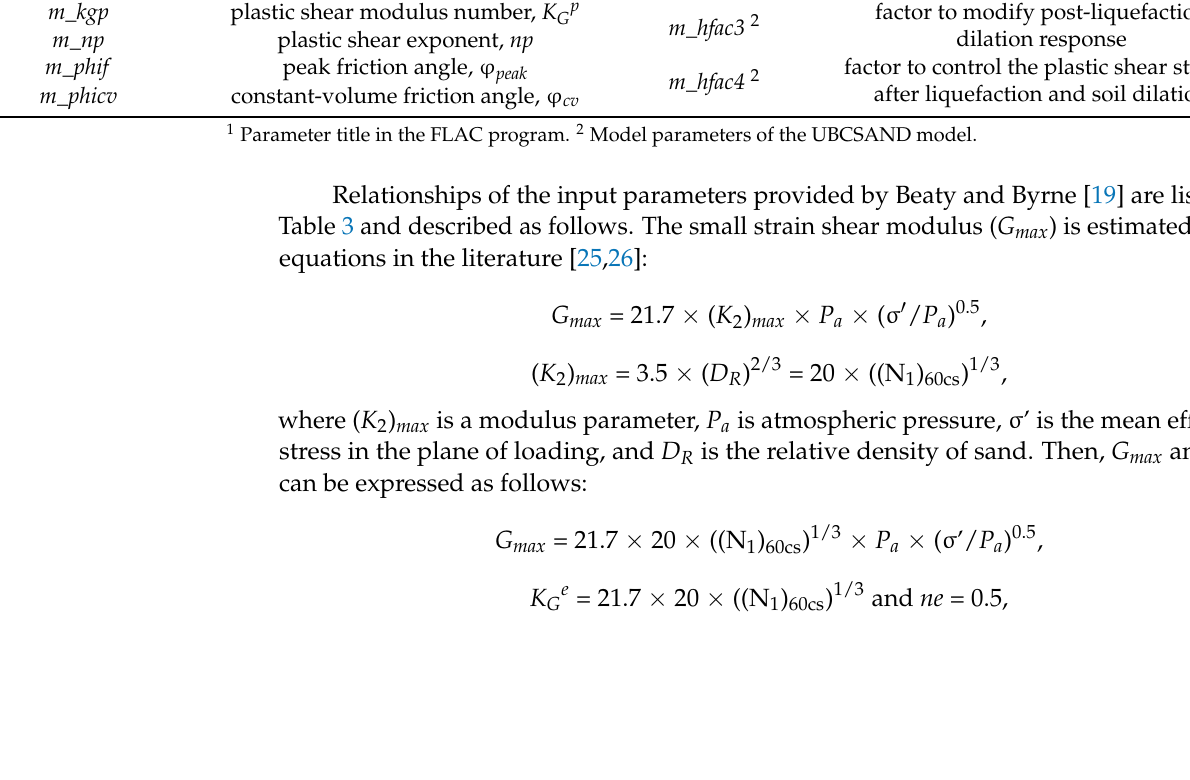
1 Parameter title in the FLAC program. 2 Model parameters of the UBCSAND